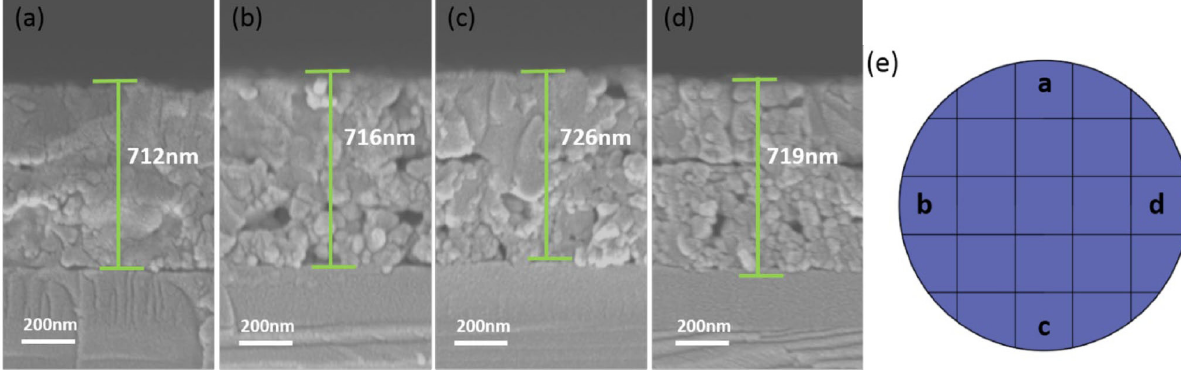
Fig. 4 Cross section of MCNO thin film annealed at 750 ℃